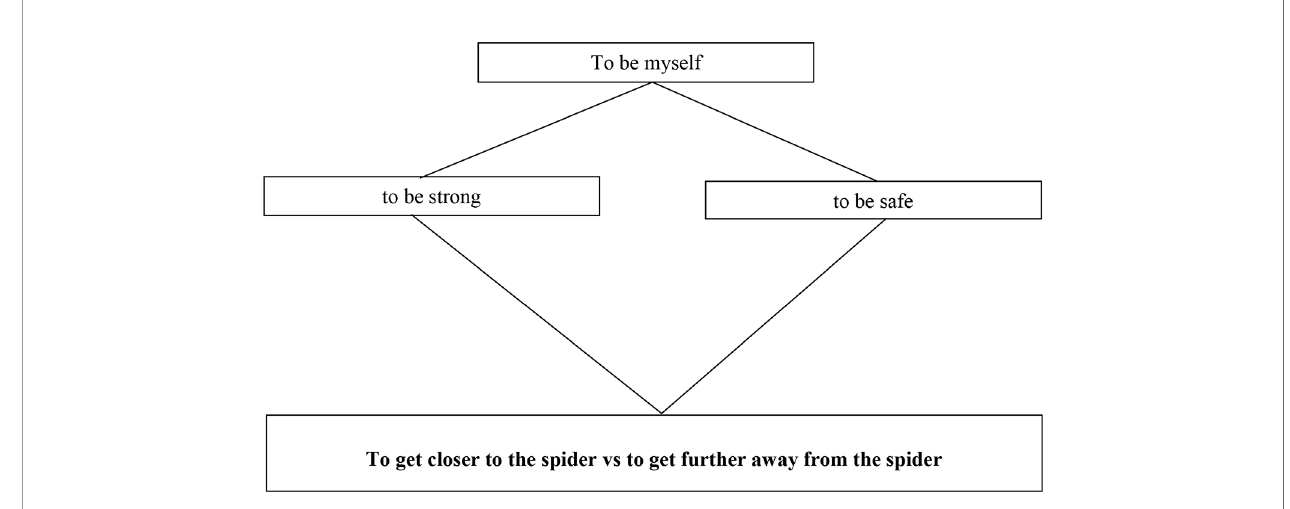
FIGURE 7 | A simpli fi ed diagram of the three-level hierarchy involved in spider phobia. The fearful individual fl uctuates in their distance from the spider depending on whether they are acting “ to be strong ” and get closer, or “ to be safe ” and get further away. However, when the same individual is provided with the opportunity to talk about their con fl ict and shift and sustain their awareness to the level setting these goals —” to be myself ”— this permits trial-and-error reorganization of the higher- level system (e.g., sets different gains for each of the mid-level goals) such that the con fl ict is reduced and control